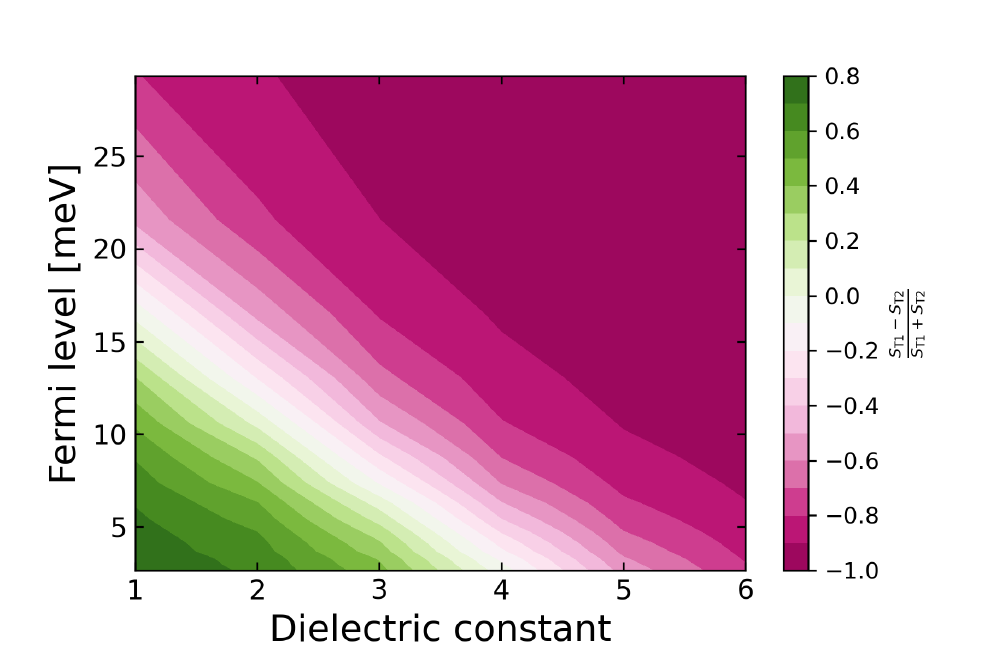
Figure 4. Dependence of the oscillator strength S T color scale shows the ratio ( S T